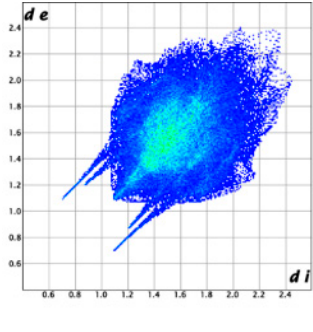
Figure 8. Hirshfeld surfaces of the BE_IV (top) and BE_I (bottom) together with the neighboring interacting molecules via hydrogen bonds and C-H … π contacts.